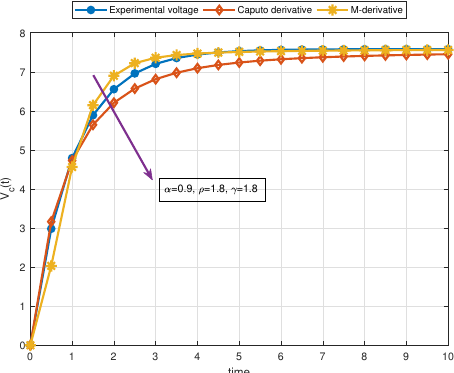
Figure 17. Comparison of the non-local M -derivative and Caputo derivative with experimental data for different values of α , ρ , and γ under the Resistance-Capacitance (RC) circuit including constant source when α = 0.9, ρ = 1.8, γ = 1.8, R = 10 Ω , C = 1000 F, e 0 = 7.58, and V c ( 0 ) =